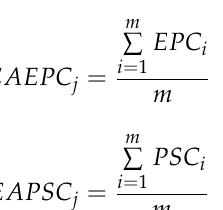
Figure 4. Quadrant chart for National Key Ecological Function County categorization. Table 4. Quadrant analysis for National Key Ecological Function County categorization.